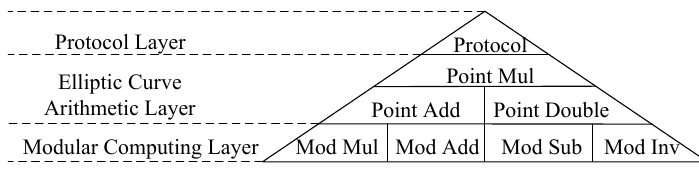
Figure 2. ECC algorithm